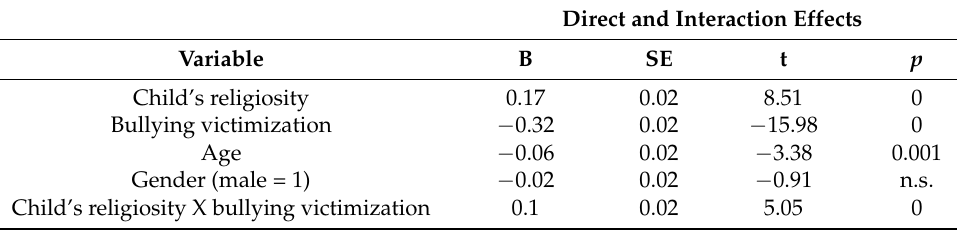
Table 3. Regression results of the moderation model predicting subjective well-being (Subjective Well-Being Scale—SWBS) (N =